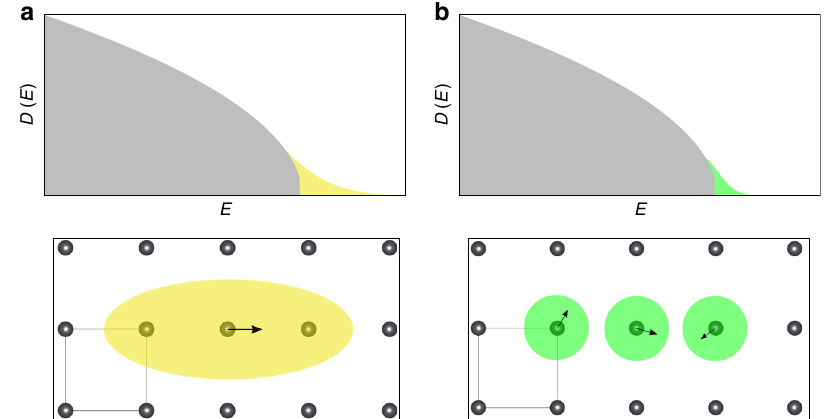
Fig. 4 Impact of differently correlated disorder potentials on the electronic states. a Long-range correlated disorder induced by a single displacement (signi fi ed by the arrow) that leads to a long-range disorder potential, illustrated as a yellow disorder domain. It implies a larger amount of tail states in the electronic density of states, D(E) , since larger parts of the crystal volume are perturbed by each disordered nuclear con fi guration. b Short-range correlated disorder is illustrated by green disorder domains in the lower panels that are characterized by uncorrelated displacements (signi fi ed by the arrows). It leads to a small amount of tail states in D(E) , since only small parts of the crystal volume are perturbed by each disordered nuclear con fi